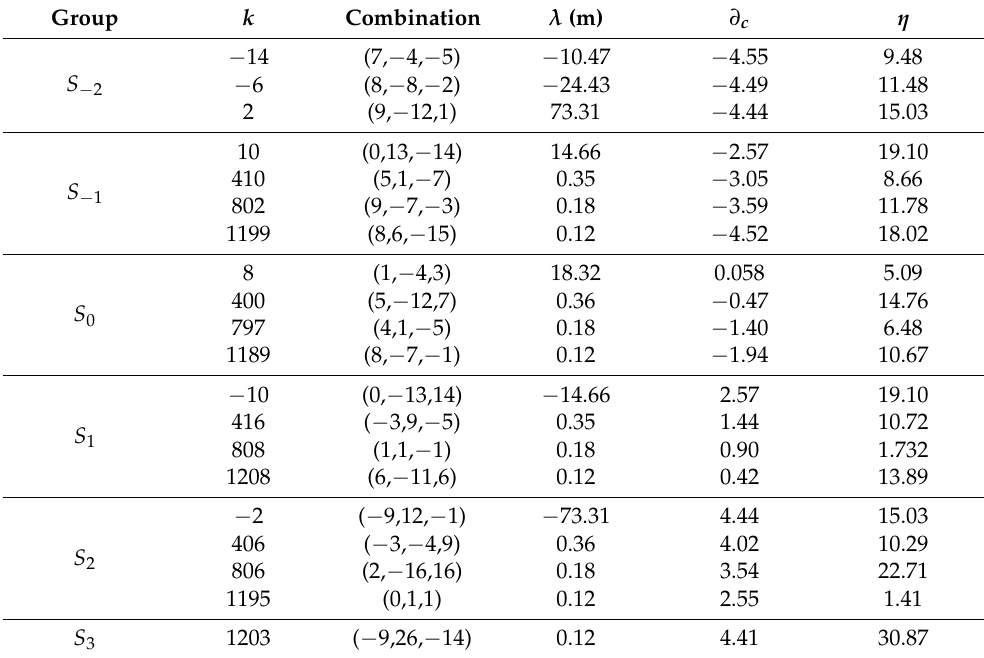
Table 3. The combined wavelength, the combined ionospheric scale factor, and the combined noise amplification factor of typical combinations under different groups.